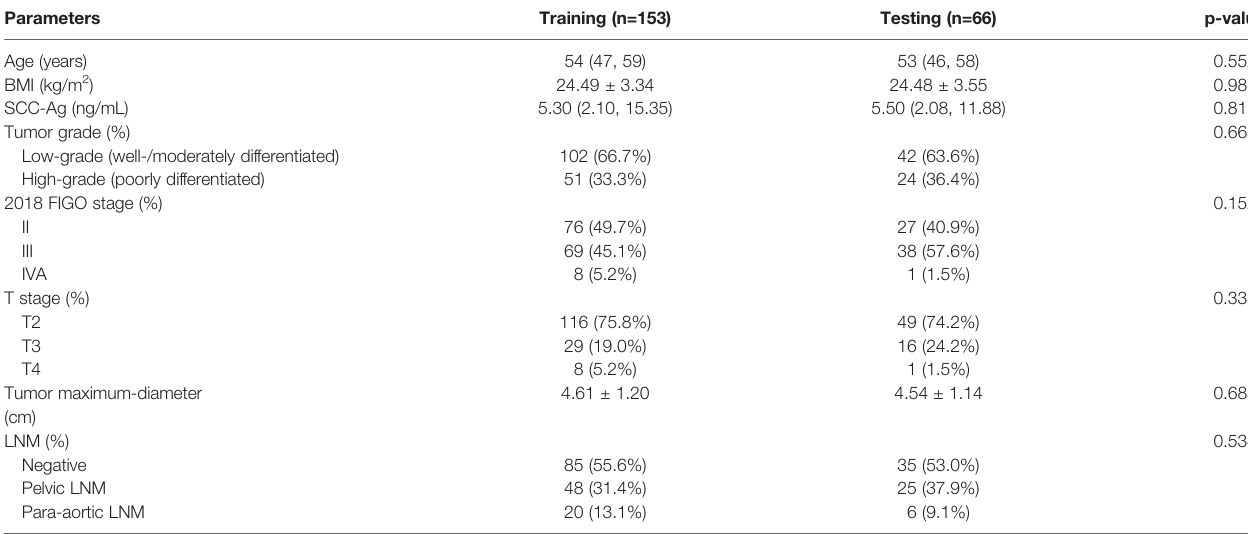
TABLE 2 | Comparison of clinical variables between training and testing cohorts.